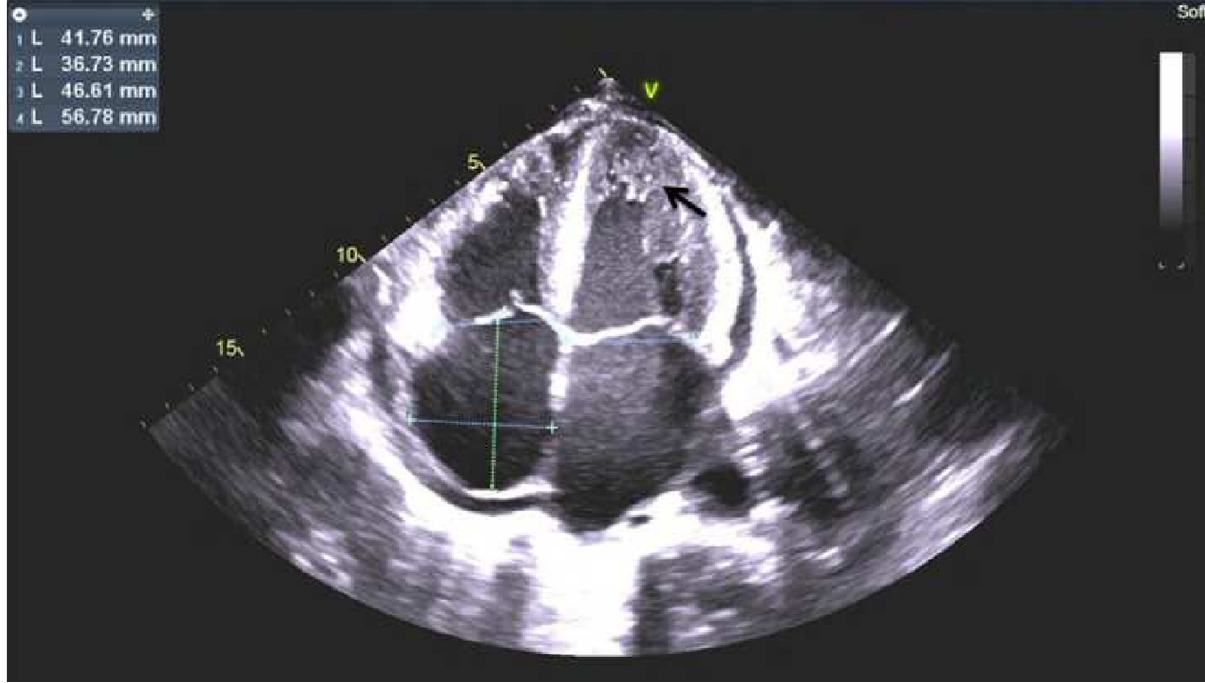
Figure 3: Echocardiography showing increased ventricular mass and granular sparkling pattern of myocardium ( black arrows )